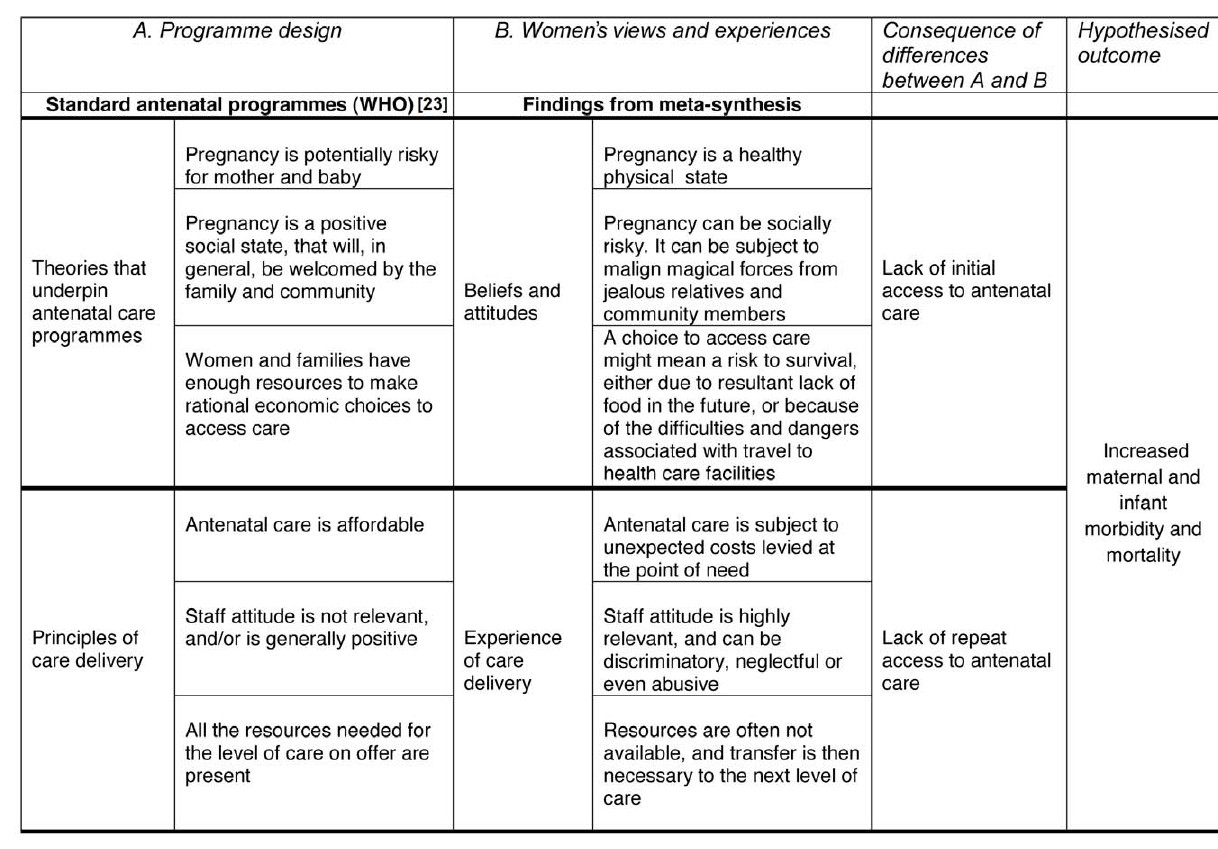
Figure 2. Hypothetical model of inadequate access to antenatal care in low and middle income countries.